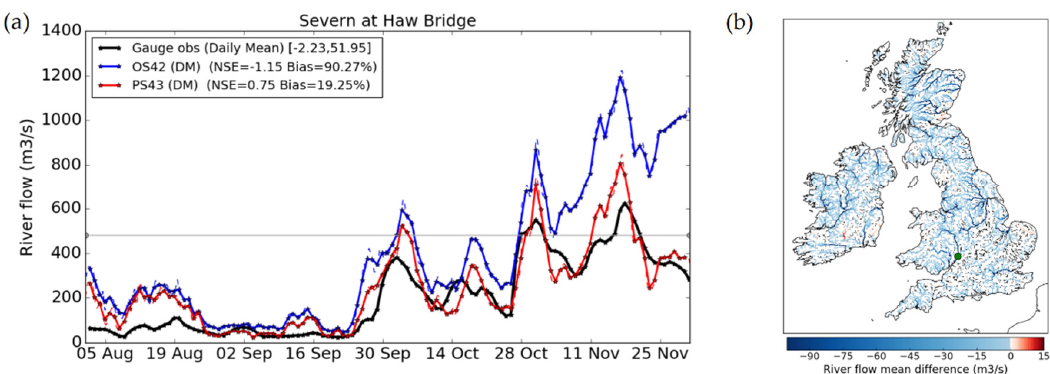
Figure 8. ( a ) Comparison of observed daily mean river flow at the Haw Bridge gauge on the River Severn between 1 August and 1 December, 2019, compared to simulated river flow using OS42 (blue) and PS43 (red) input runoffs. The Nash-Sutcliffe efficiency (NS) and bias metrics for each simulation are listed. ( b ) Monthly mean difference between simulated the river flow using PS43 and OS42 runoffs during November 2019. Blue regions show PS43 flows lower than OS42. Regions where differences are within ±0.5 m 3 s -1 are masked for clarity and flow differences plotted on top of a map of the river routing grid (black lines). The location of the Haw Bridge gauge is marked by the green circle.